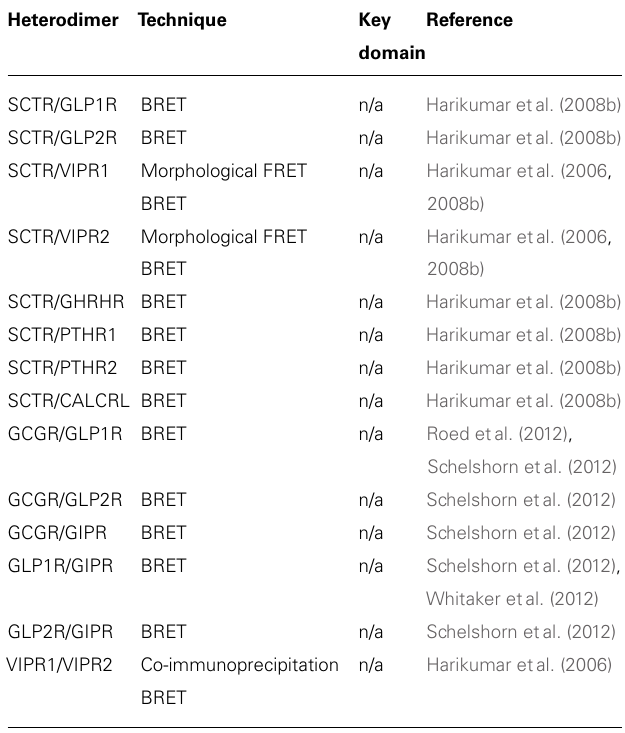
Table 2 | Heterodimerization of class B